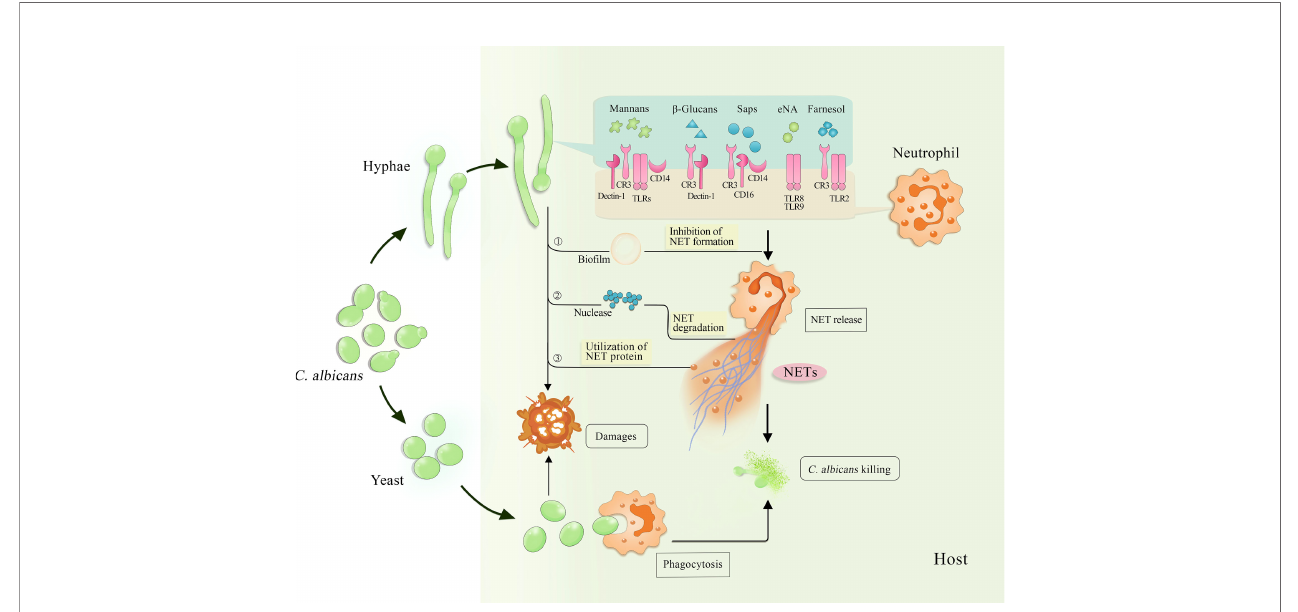
FIGURE 1 | Interaction among C. albicans , neutrophils and NETs. The invading C. albicans can be cleared by neutrophils through different killing approaches, such as phagocytosis targeted to yeast and NET release induced by hyphae. Several stimuli derived from C. albicans hyphae, including mannans, b -glucans, Saps, eNA and farnesol, activate various receptors on the surface of neutrophils and trigger NET release. Consequently, NETs capture and kill both yeast and hyphae. Furthermore, C. albicans inhibits NET release by forming bio fi lms and degrades NETs by secreting nuclease, while using NET proteins to strengthen their invasiveness. NETs, neutrophil extracellular traps; Saps, secreted aspartic proteases; eNA, extracellular nucleic acids; CR3, complement receptor 3; TLRs, toll-like